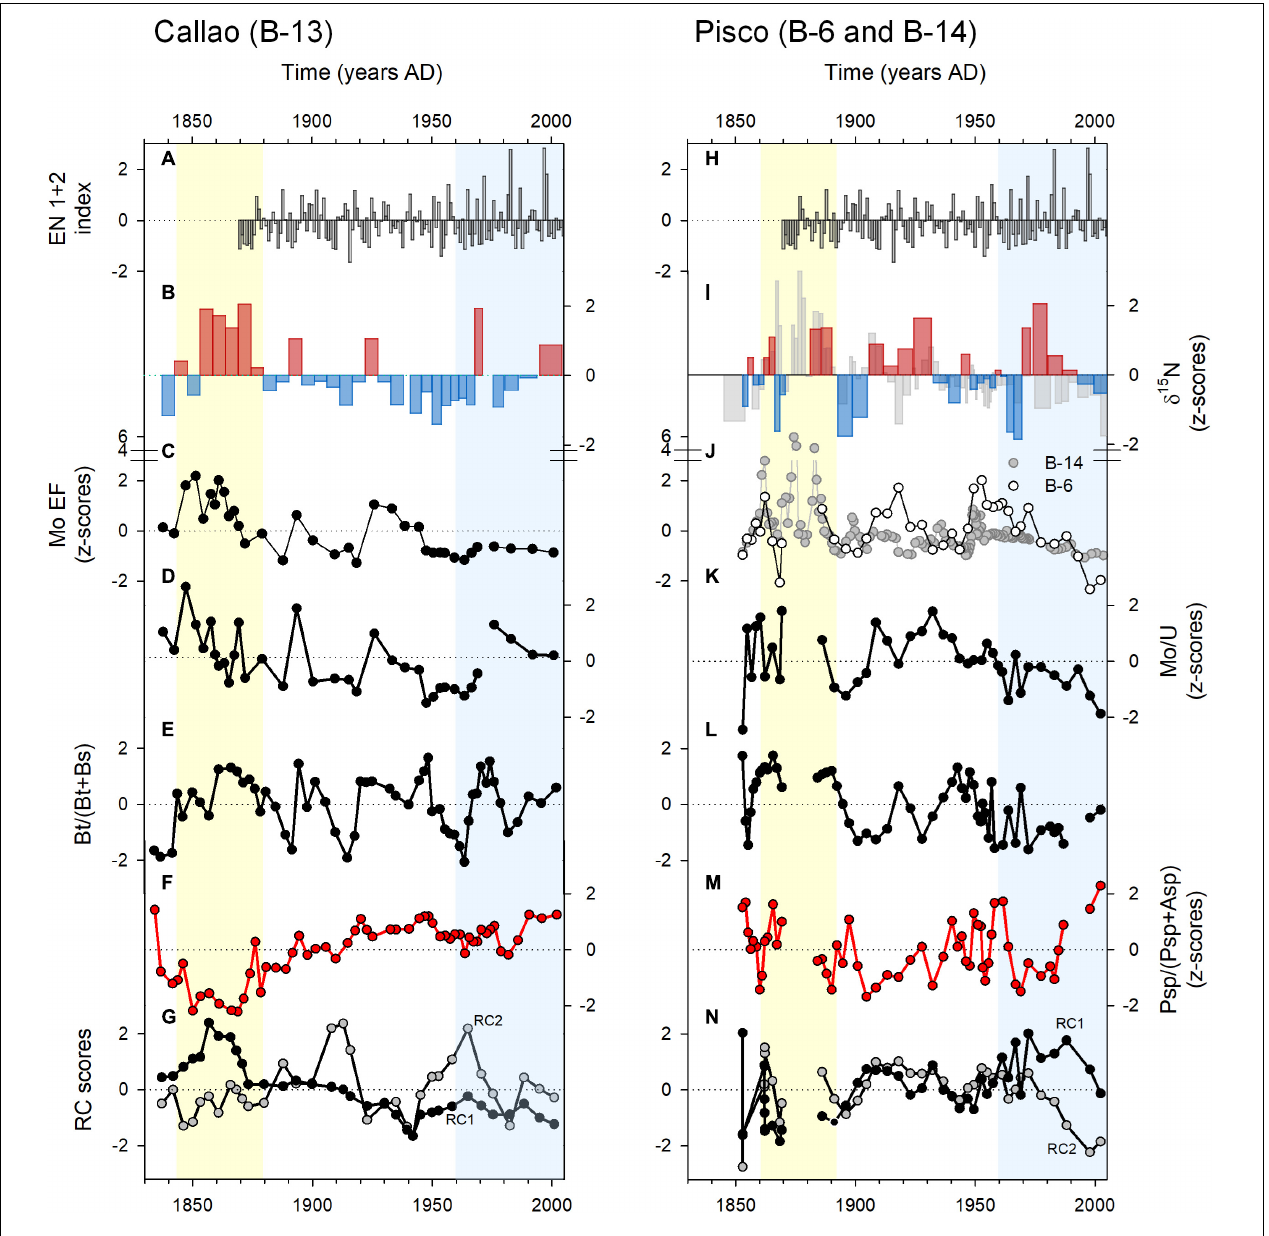
FIGURE 6 | Trends of geochemical and foraminiferal proxies in Callao (left panel) and Pisco (right panel) along to ENSO index (EN 1+2; A,H ): δ 15 N anomalies (B,I) , as a proxy of water-column denitrification; Mo EF (C,J) as proxy of intensity of anoxia; Mo/U ratio (D,K) as proxy of suboxic (low values) vs. sulfidic (high values) conditions; Bt/(Bt+Bs) index (E,L) ; A sp /(A sp +P sp ) index (F,M) ; and PC scores from Figure 5 as indicators of redox conditions [RC1 of B-13 (G) and RC2 of B-6 (N)